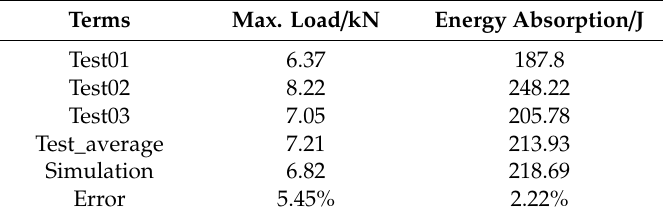
Figure 6. Comparison between test and simulation at the component level. ( a ) Force–displacement curve. ( b ) Energy absorption–displacement curve. Table 2. Maximum load and energy absorption from the tests and simulation.